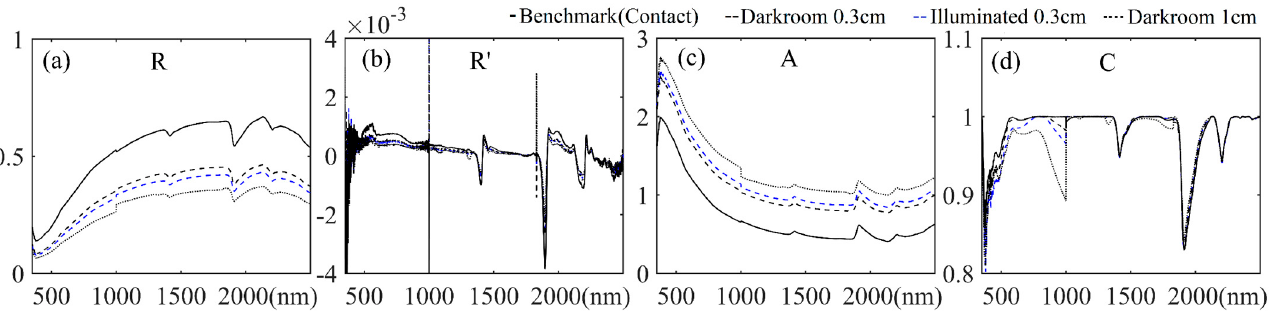
Table 3. Estimation accuracy of PLS models in the light interference control experiment.